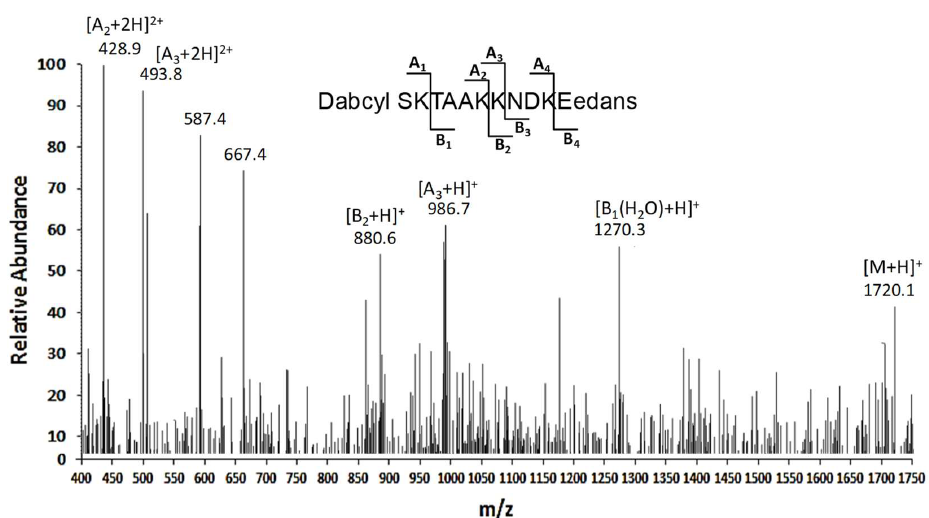
Figure 2. Characterization of the proteolytic sites in a peptide substrate containing the APE1 26-36 portion. ESI-IT-MS analysis of the digest from the treatment of DABCYL- 26 SKTAAKKNDK 36 E-EDANS with a whole OCI/AML3 cell extract. The peaks corresponding to the substrate and hydrolysis products are indicated ( m / z , mass-to-charge ratio).